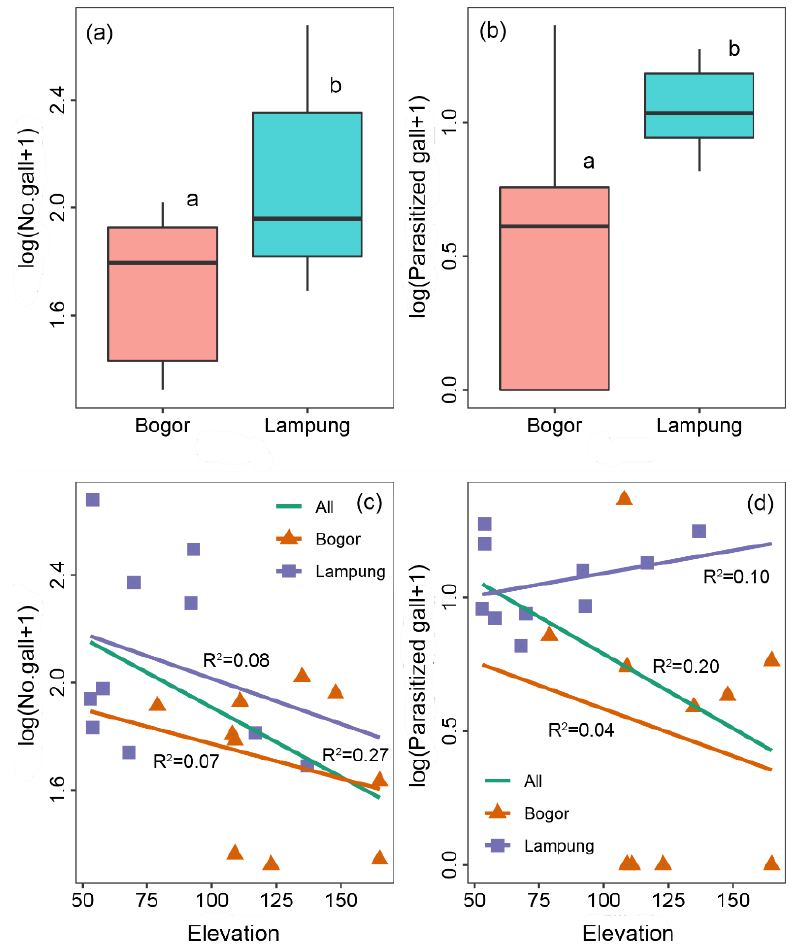
Figure 5. Difference of ( a ) gall numbers and ( b ) parasitized gall between Bogor and Lampung and the relationship between elevation (m above sea level) and ( c ) gall numbers and ( d ) parasitized gall. Data were transformed to log(x + 1) to achieve normal distribution. Boxplots with different letters are significantly different at p < 0.05 according to Tukey’s test.